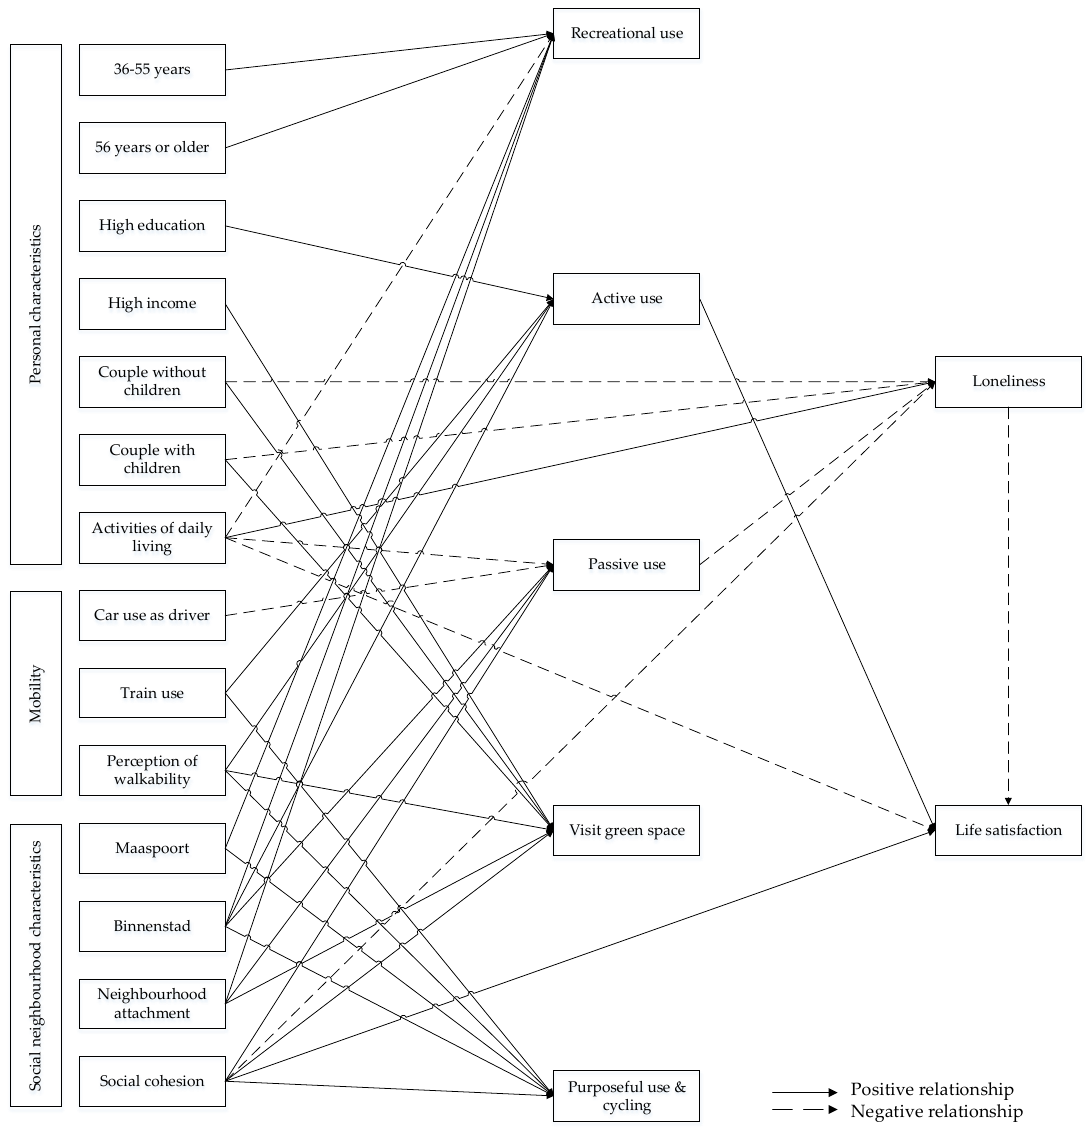
Figure 3. Relationships in path model.